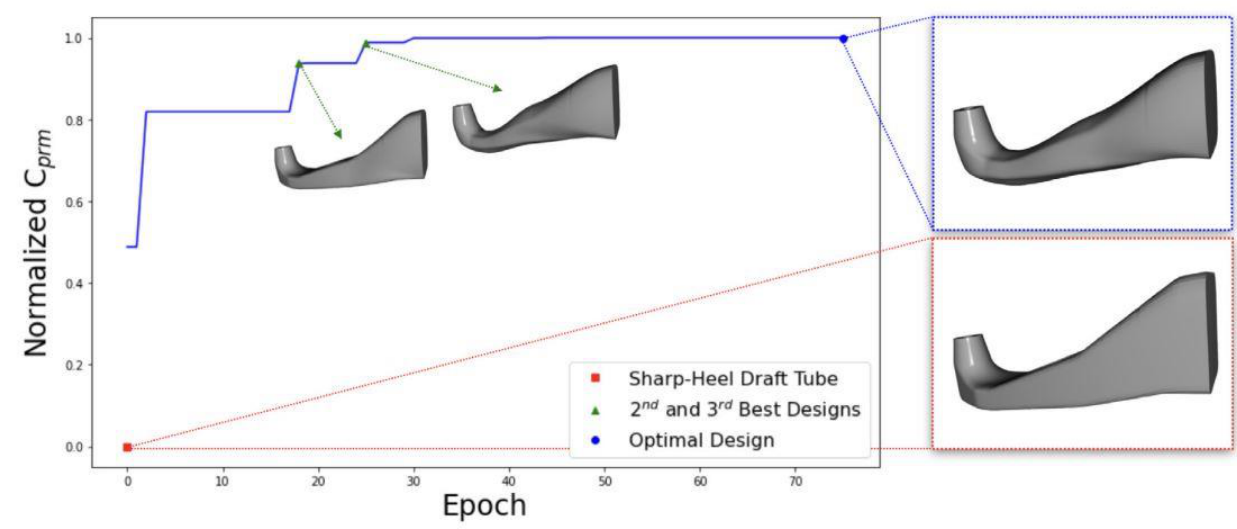
Figure 5. Optimization progress [10].